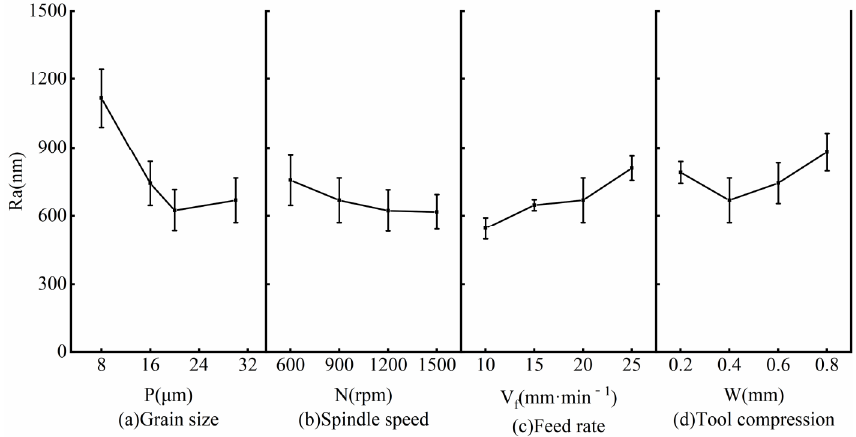
Figure 6. Influence of grinding parameters on surface roughness: ( a ) Grain size, ( b ) Spindle speed, ( c ) Feed rate, ( d ) Tool